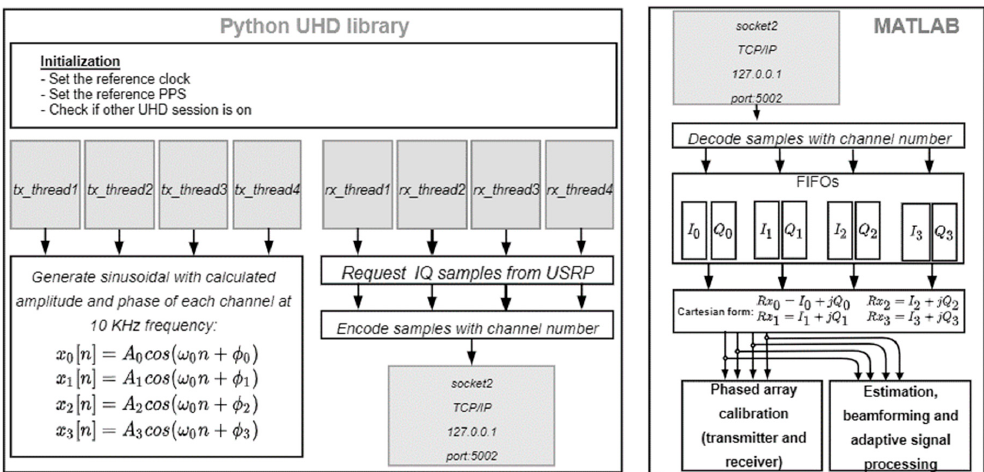
Figure 4. Flow control between the receiver and transmitter during Python and Matlab interfaces.